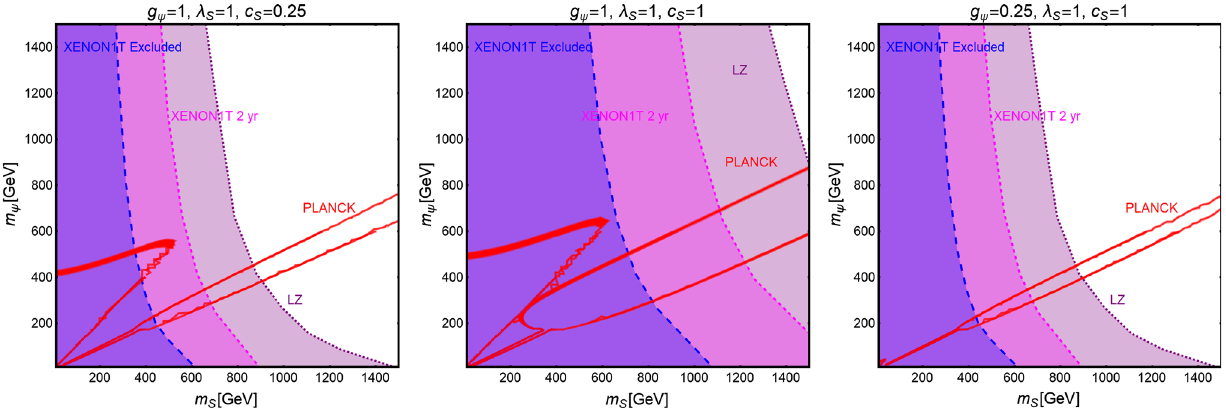
Fig. 10 The same as Fig. 9 but for a Dirac fermion DM, i.e., replacing λ S χ , m χ by g ψ , m ψ ,